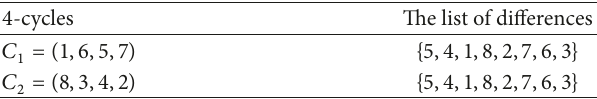
Table 1: The list of differences from S = {𝐶 1 , 𝐶 2 } .